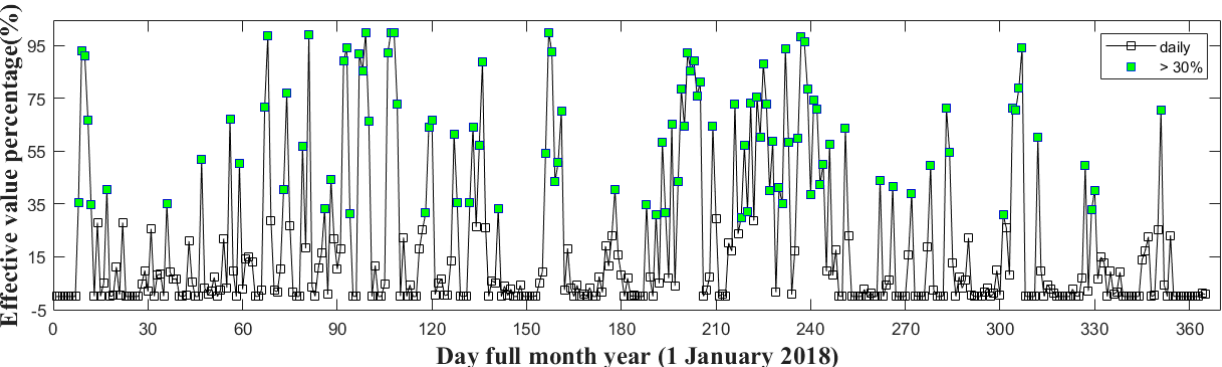
Figure 3. Percentage of MODIS LST pixels with valid values in the study area and their change with the day of the year.